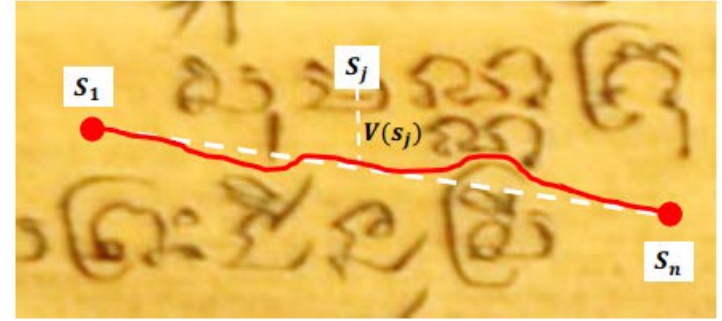
to goal state . Figure 4. An example of an optimal path going from start state S 1 to goal state S n 𝑆𝑆 1 𝑆𝑆 𝑛𝑛